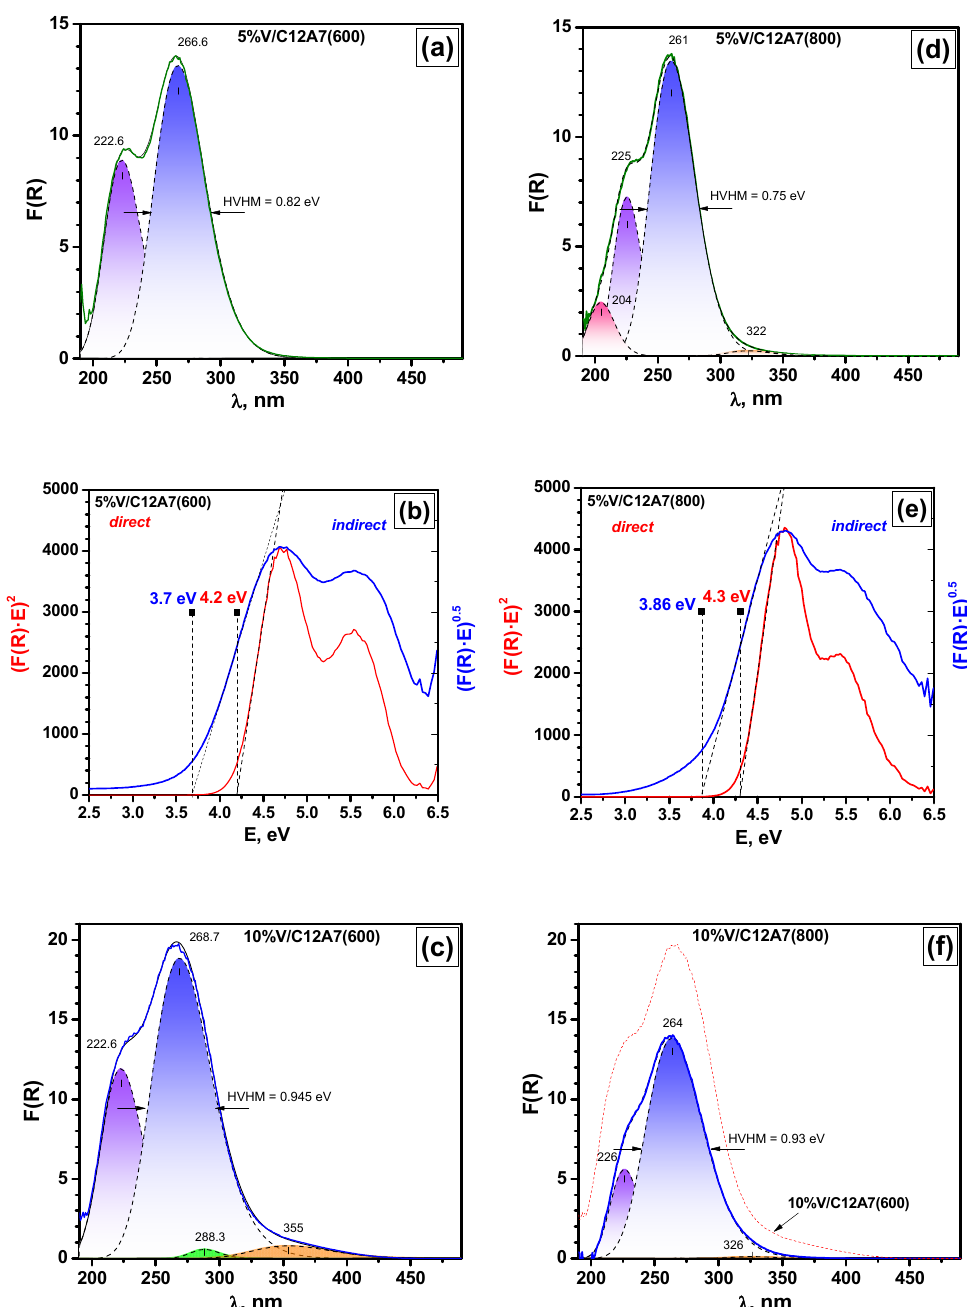
Figure 5. Diffuse reflectance UV–Vis spectra of 5%V/C12A7 sample calcined at 600 ◦ C ( a ) and 800 ◦ C ( d ). Dependences of ( F ( R ) · E ) 2 and ( F ( R ) · E ) 0.5 on E characterizing the energy gap width E g (direct and indirect) for 5%V/C12A7 sample calcined at 600 ◦ C ( b ) and 800 ◦ C ( e ). Diffuse reflectance UV–Vis spectra of 10%V/C12A7 sample calcined at 600 ◦ C ( c ) and 800 ◦ C ( f